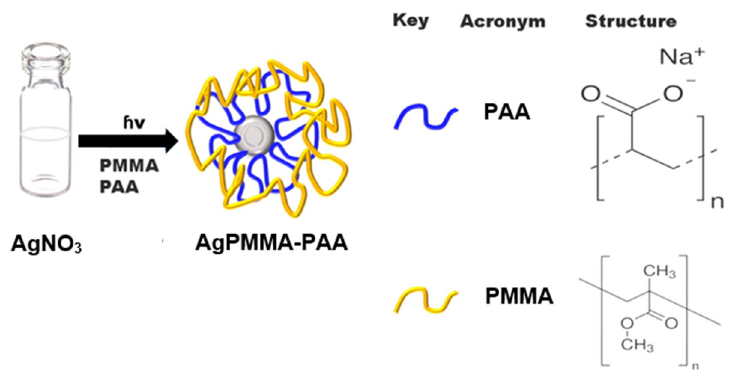
Figure 2. Scheme showing the synthetic protocol of the Ag-PMMA-PAA nanoparticle preparation, where silver nanoparticles were formed in PAA and PMMA.